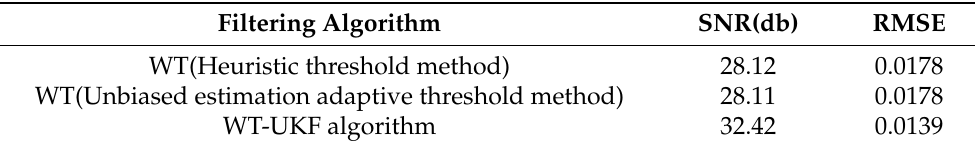
Table 2. Comparison of the effects of different denoising methods (MIT-BIH arrhythmia database).